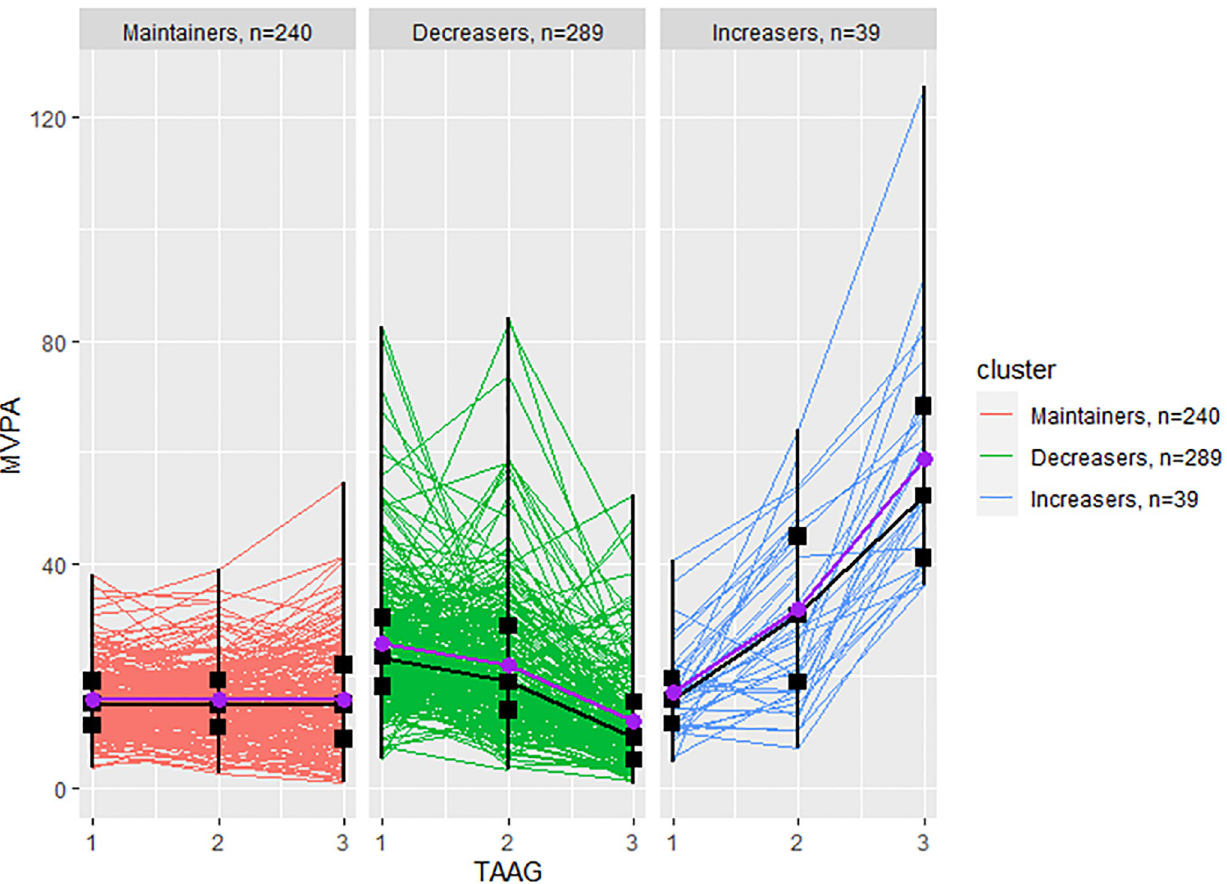
Fig 2. Individual MVPA trajectories in each cluster. Individual moderate-to-vigorous physical activity (MVPA) trajectories of the three clusters over the three TAAG waves at ages 14, 17, and 23, where the red lines are for the Maintainers, the green lines are for the Decreasers, and the blue lines are for the Increasers. The median and interquartile range per TAAG wave in each cluster are plotted over the trajectories in black, and the mean per TAAG wave in each cluster is plotted over the trajectories in purple.